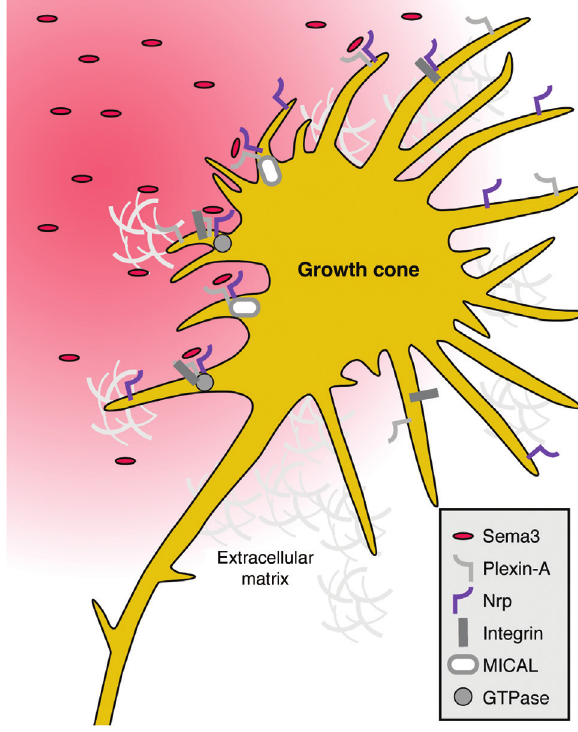
Figure 3 Nrp critically modulates neuronal growth cone function. Nrp is expressed in the axonal growth cone of migrating neurons where it couples with plexin receptors in responding to the guid- ance cue Sema3. Nrp functions by coupling high-affinity ligand binding to plexin-dependent cytoskeletal rearrangement through different GTPases and